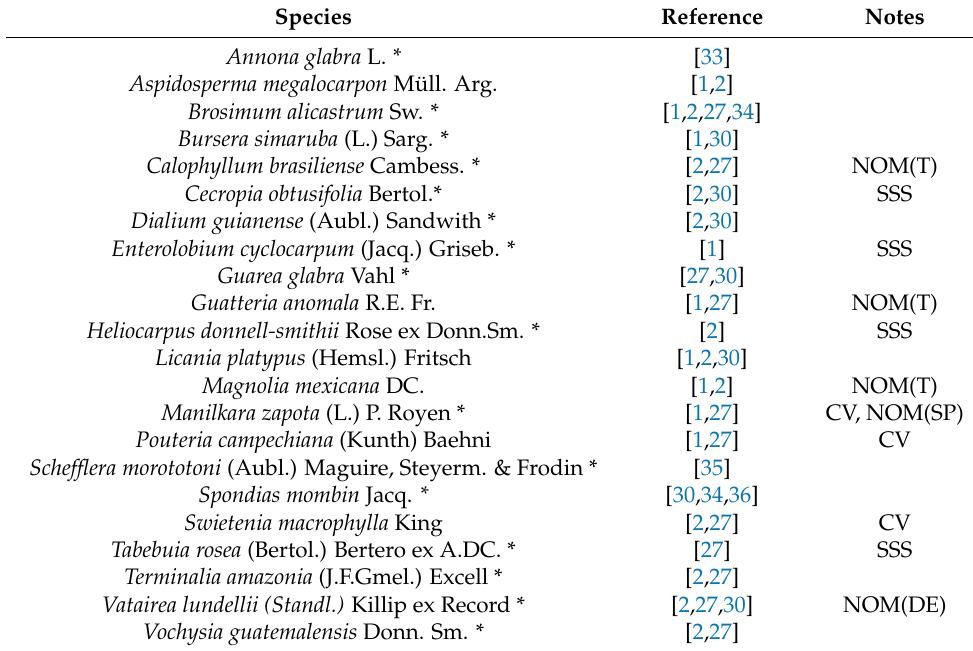
Table 1. Species with ecological and forest importance for Mexico’s tropical rainforest.